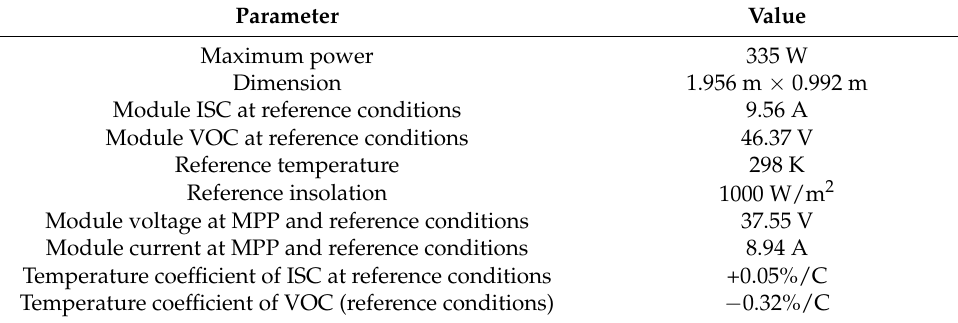
Table 8. PV panel characteristics